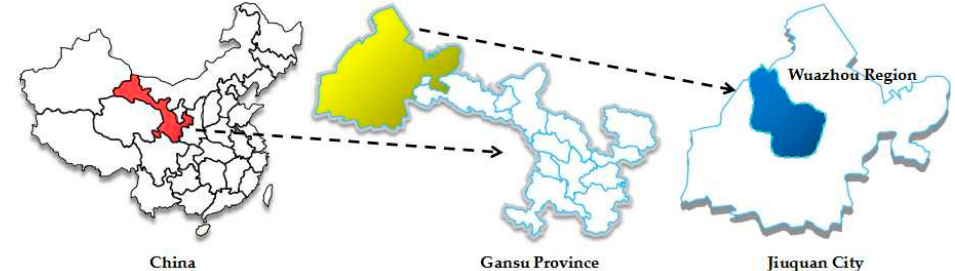
Figure 4. The geographical location of Guazhou Region.